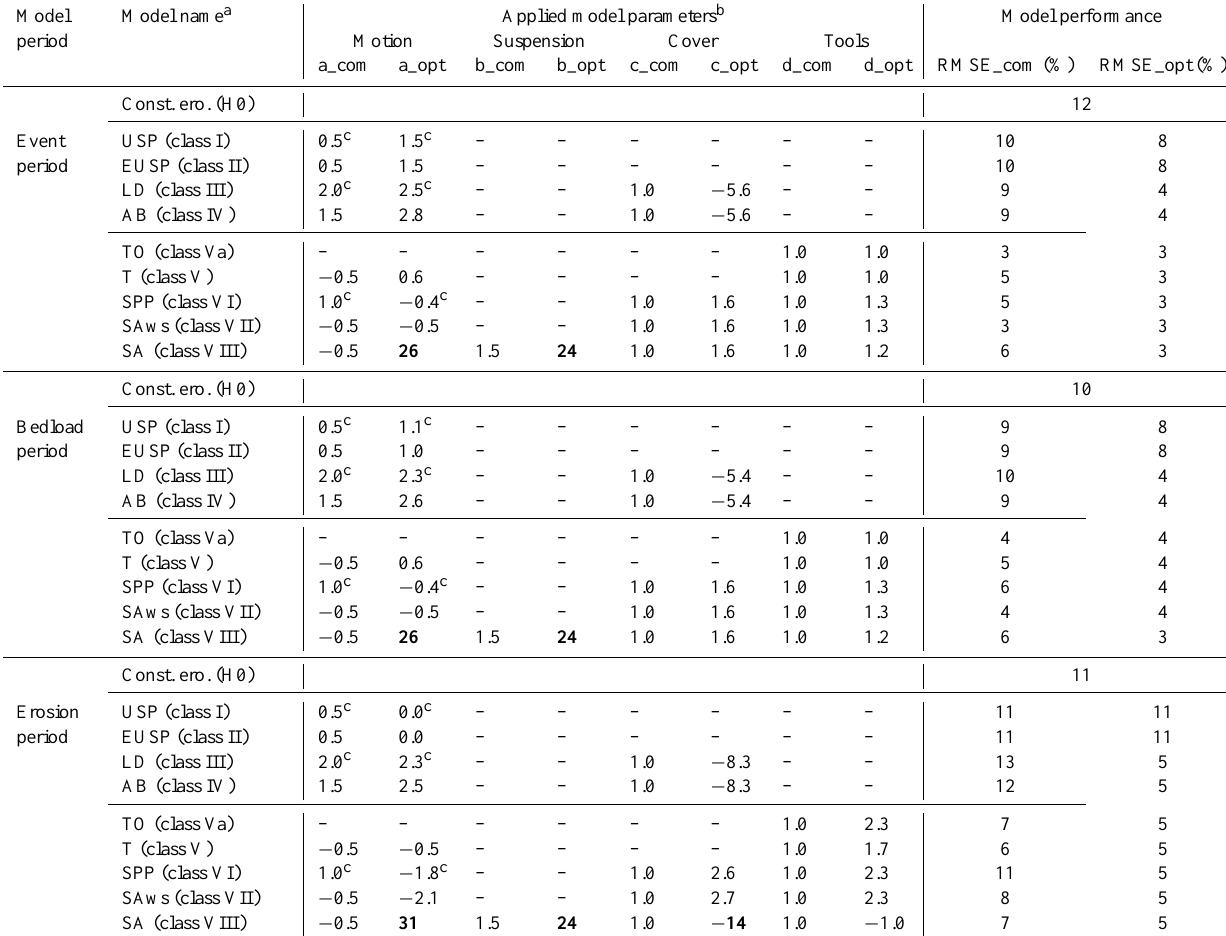
Table 3. Exponents of the four sediment effects (cf. Eq. 1) for the common (com) and optimized (opt) model versions, respectively, given for the three simulation time periods under consideration and the resulting model performance relative to c3i. Implausible parameters are indicated in bold and model groups with and without the tools effect are separated by a horizontal